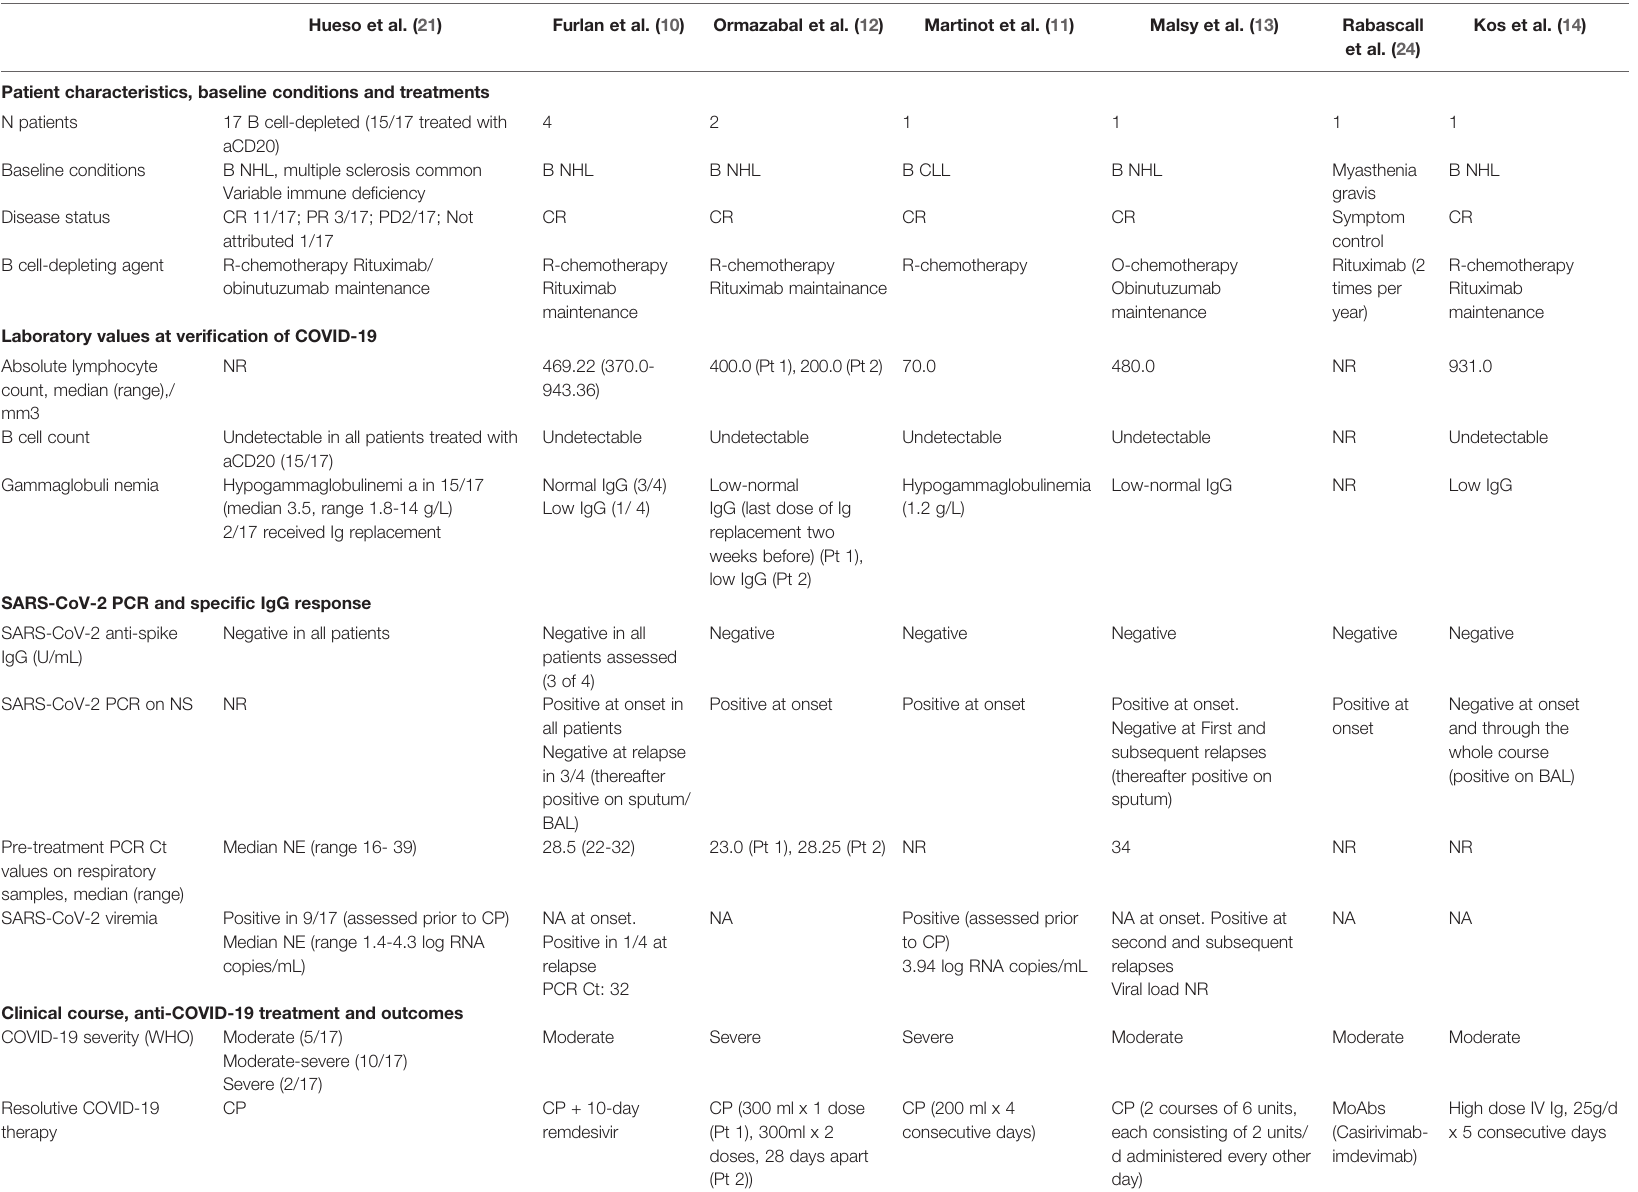
TABLE 1 | Reports on immunotherapy strategies in B cell-depleted patients after aCD20